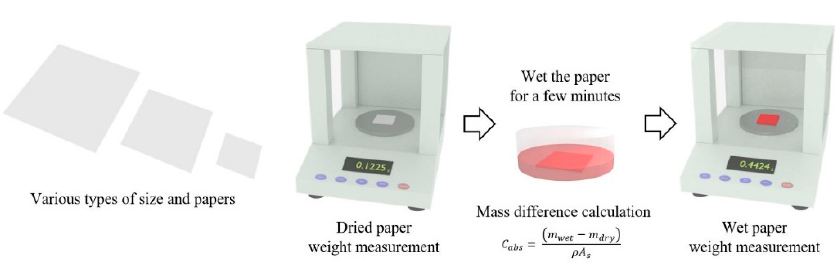
Figure 5. The experiment diagram of direct measurement of absorption capacity.